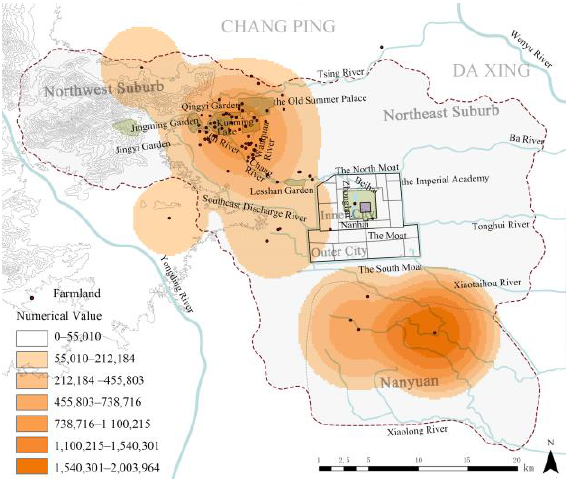
Figure 10. Spatial distribution and density analysis map of farmland.